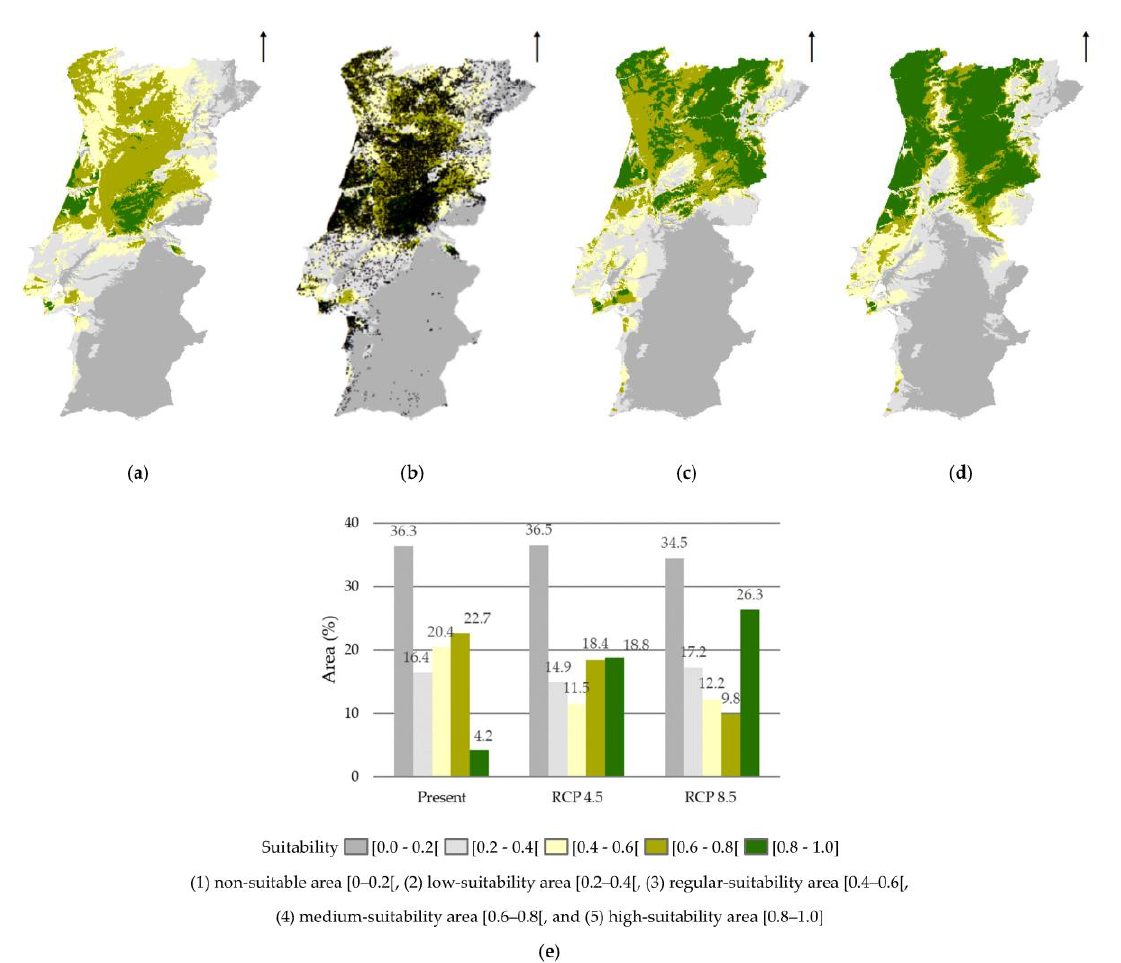
Figure 6. MaxEnt — Maritime pine potential distributions for the present and for the future under climate change scenarios: ( a ) Present; ( b ) Present with the species’ occurrences (black dots); ( c ) Future 2070 — RCP 4.5; ( d ) Future 2070 — RCP 8.5; and ( e ) Suitability areas (%) in the present and for the future (2070) under the RCP 8.5 and RCP 8.5 climate change